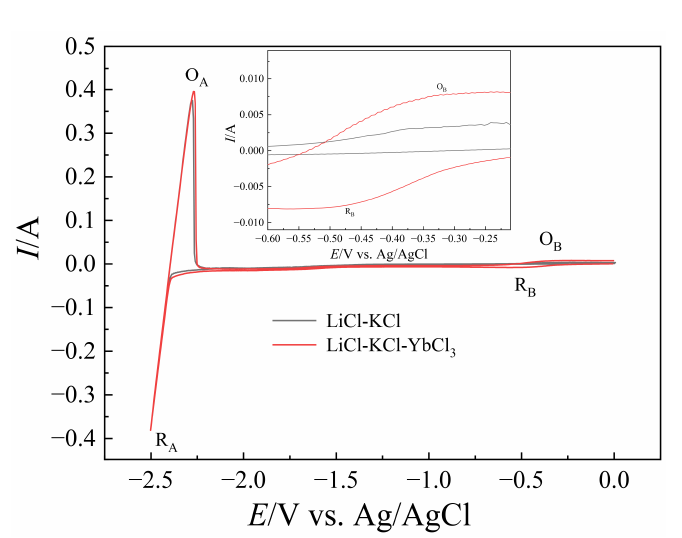
Figure 3. CVs obtained on the W electrode ( S = 0.314 cm 2 ) in the absence and presence of YbCl 3 (1.55 × 10 − 4 mol cm − 3 ) in eutectic